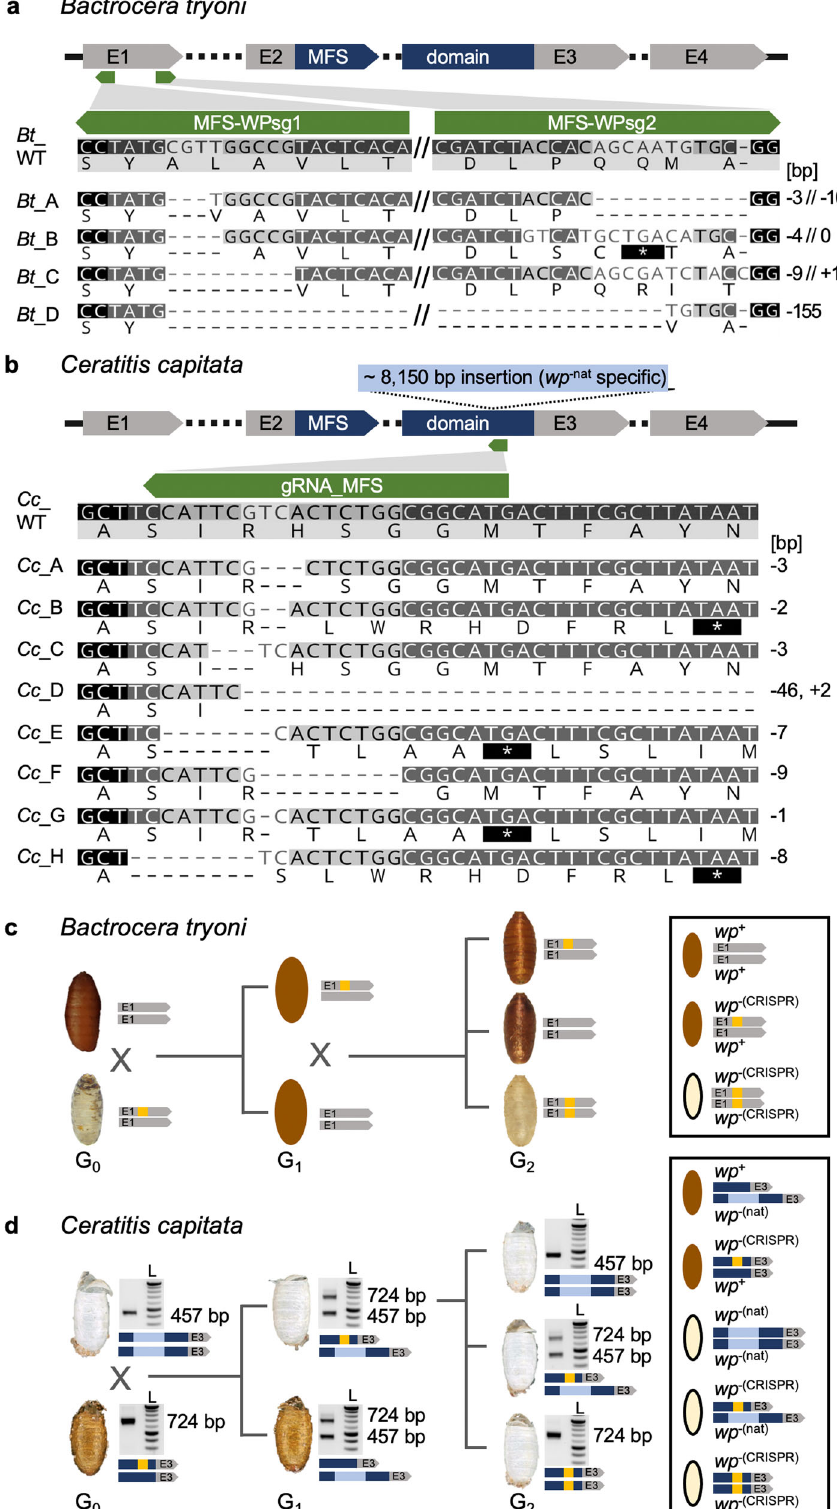
carrying the natural wp − mutation, a brown phenotype would be observed for all offspring. Here, fi ve out of 13 crosses, namely M1, M3, F2, F3, and F4, produced white pupae phenotype offspring. The crosses generated 221, 159, 70, 40, and 52 G 1 pupae, of which 10, 30, 16, 1, and 1 pupa respectively, were white. Fifty-seven fl ies